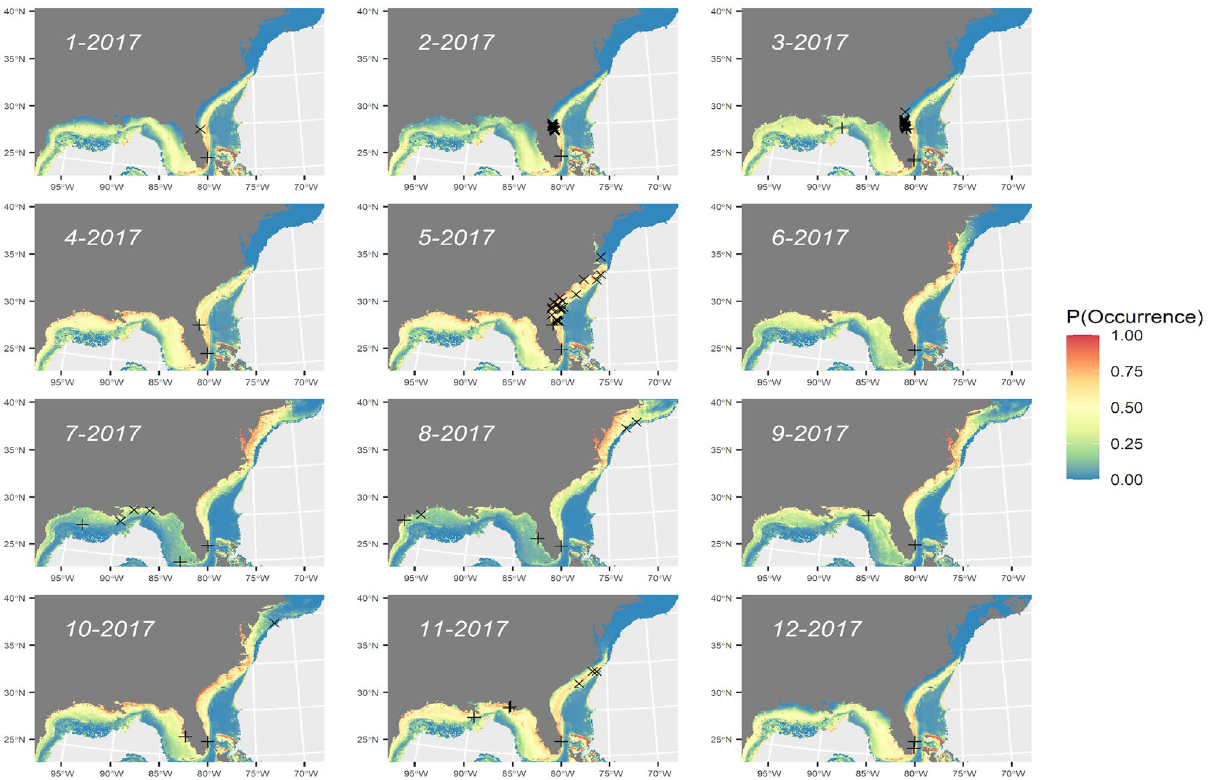
Figure 6. Predicted probability of occurrence for manta rays for combined surveys (SEFSC, NARWC, and NYSERDA) model for monthly average environmental conditions in 2017 with overlay of internal (X) and external (+) validation points. Map generated in R v. 4.1.2 (https:// cran.r- proje ct. org/ bin/ windo ws/